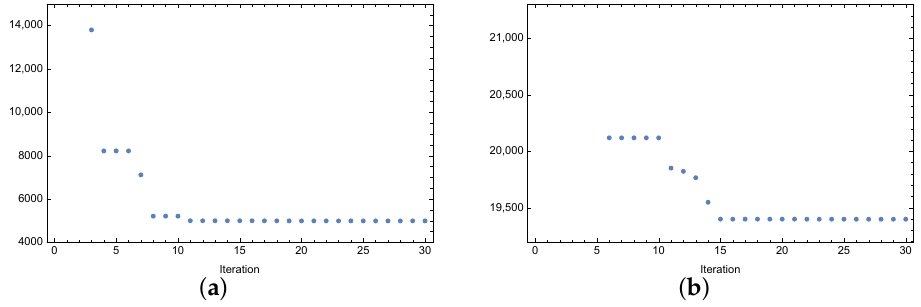
Figure 7. Values of the objective function in the case of 5% ( a ) and 10% ( b ) perturbation of the input data.